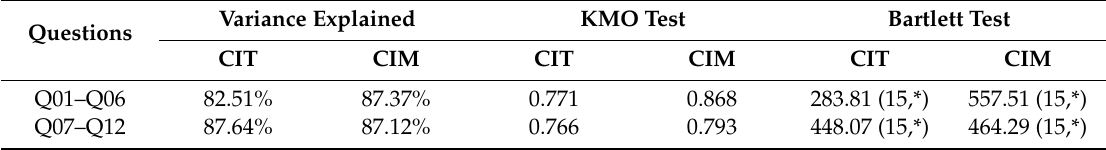
Table 15. Validity of the model confirmatory factor analysis (CFA)